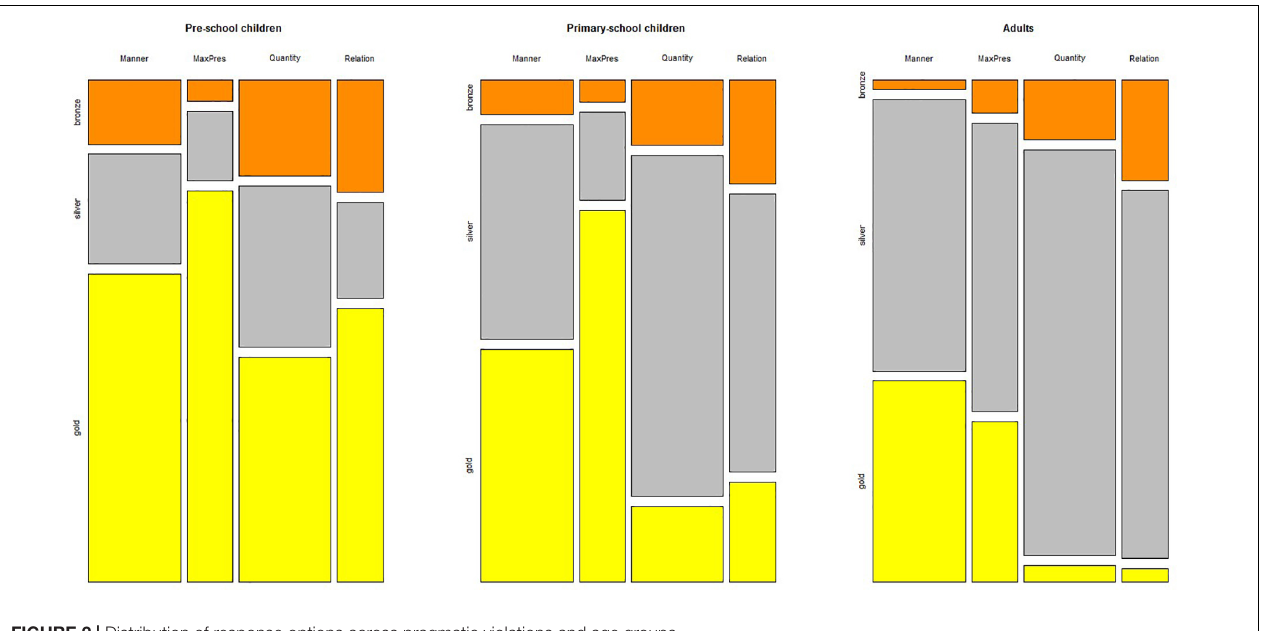
FIGURE 2 | Distribution of response options across pragmatic violations and age groups. TABLE 4 | Distribution of medals (in percentages) for all the types of violations (with the submaxims of Manner, Be brief and Be orderly, provided separately) and all age groups. Preschool children Primary-school children